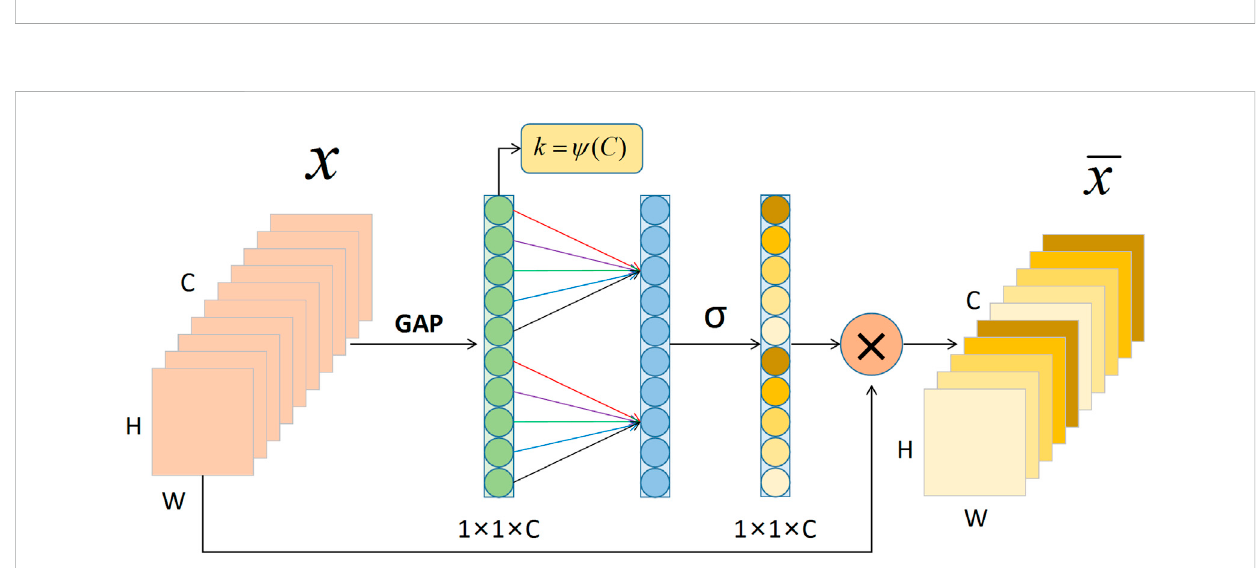
FIGURE 6 The cross-channel interactive attention module. Notes: GAP: Global Average Pooling; C: Channel dimension; H: Height; W: